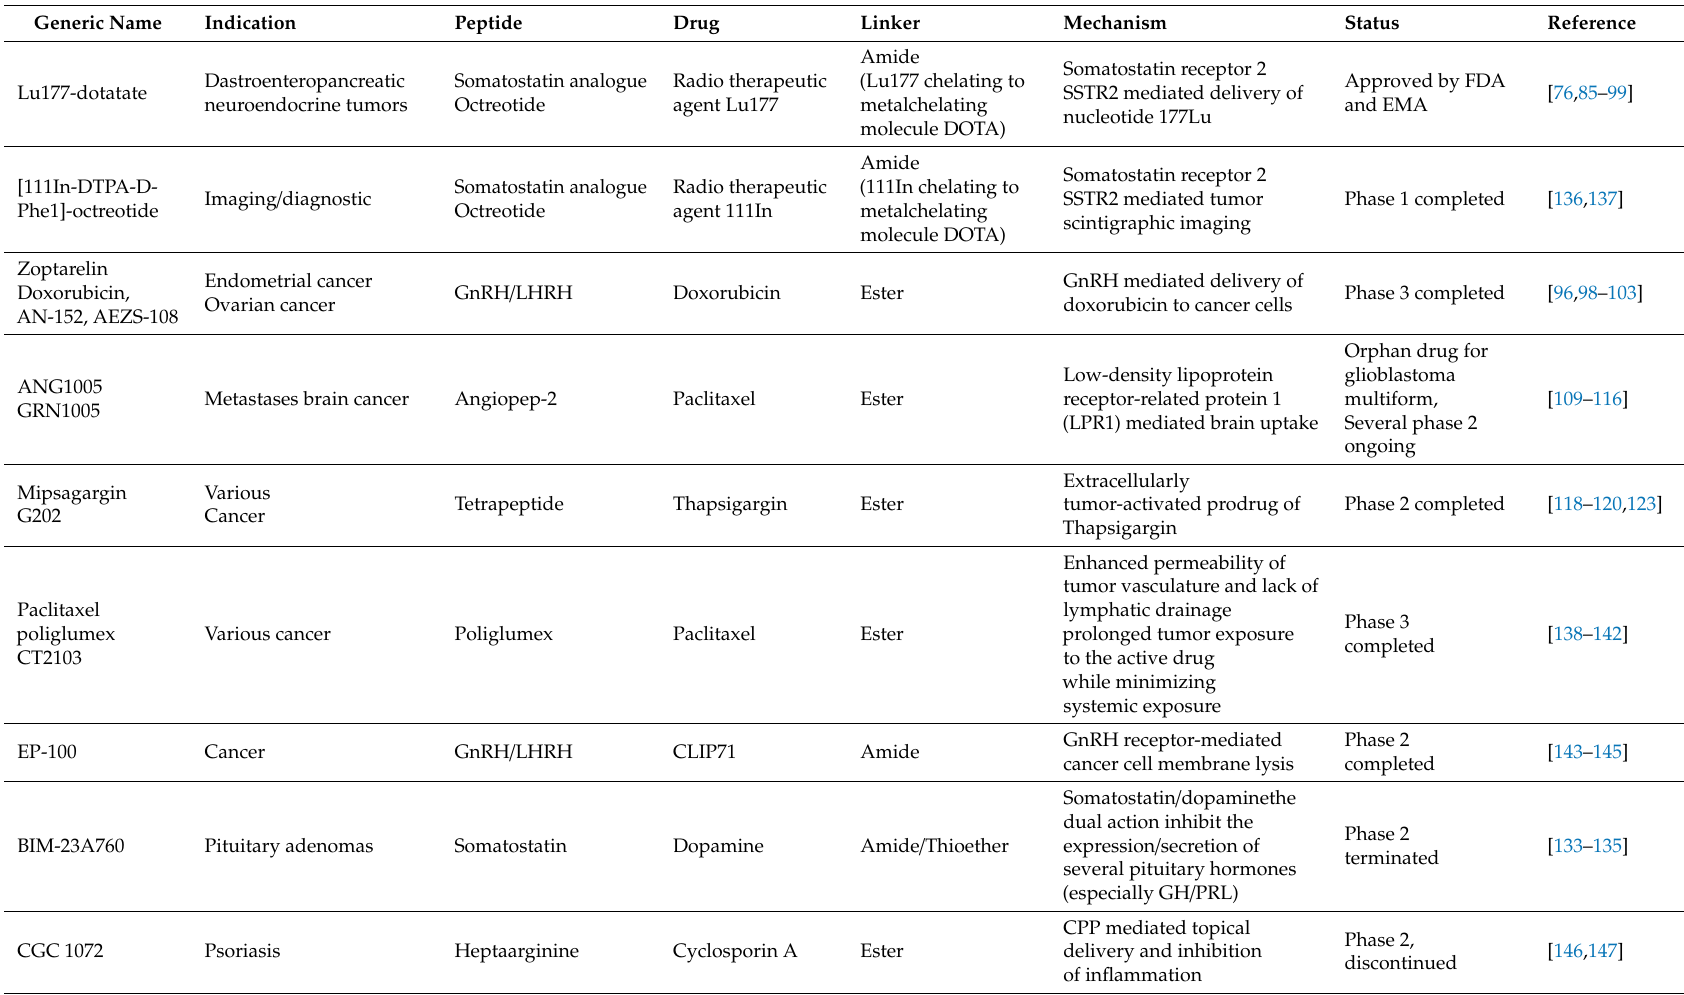
Table 1. Peptide-drug conjugates in various clinical development